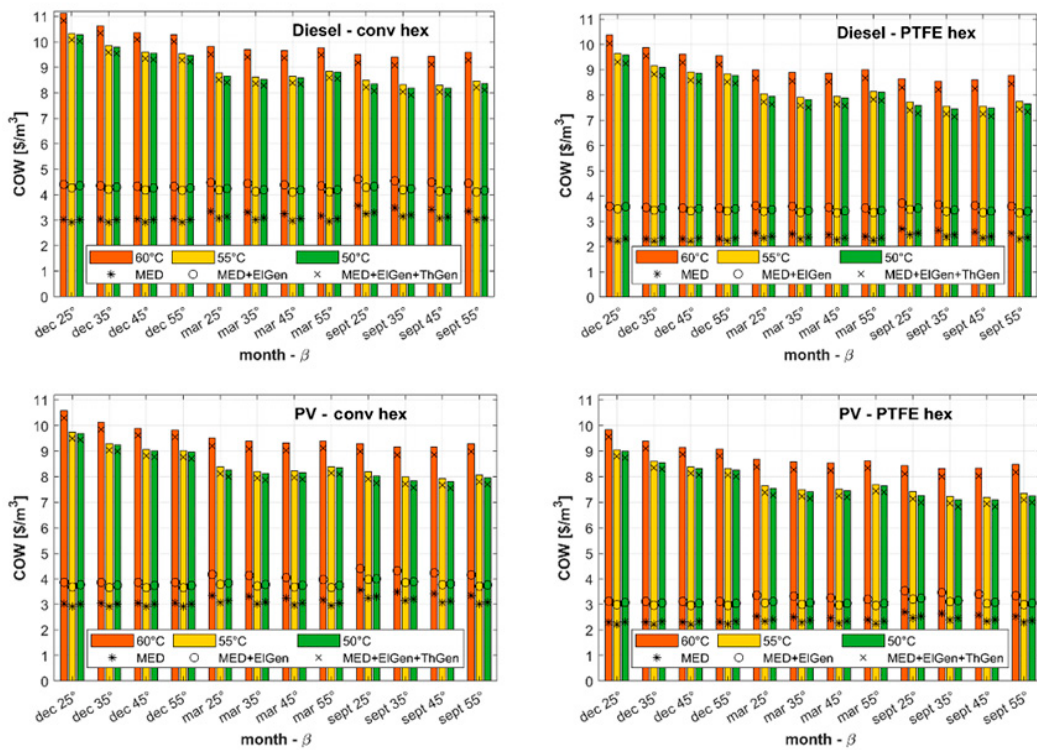
Figure 6. Cost of water (COW) with different design months, β , and top brine temperatures (TBT) for different exchangers (conventional (conv)/polytetrafluoroethylene (PTFE)) and a different electrical generation (photovoltaic (PV)/diesel).